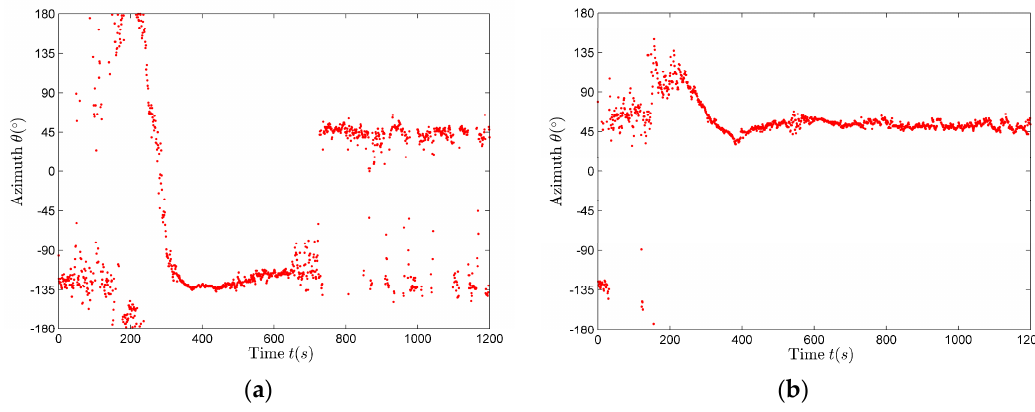
Figure 14. The azimuth estimation results. ( a ) Using the real part for calculation; ( b ) Using the imaginary part for calculation.